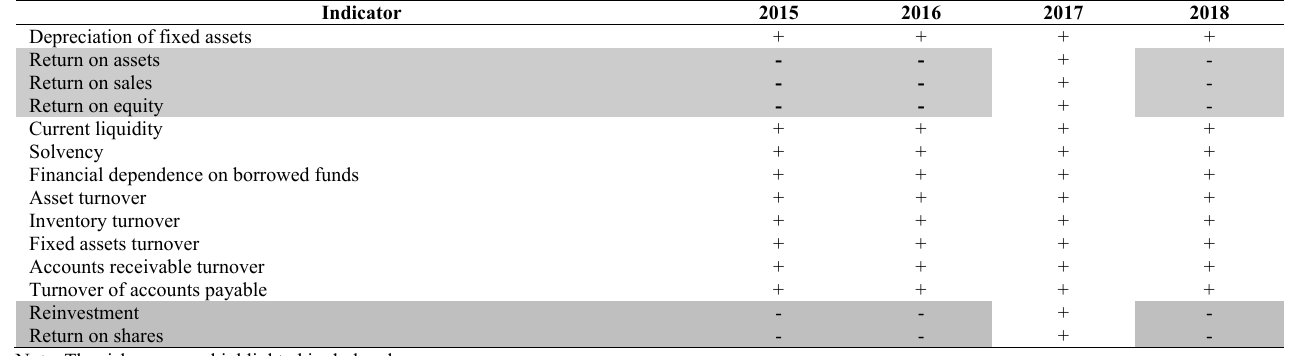
The scope of the restraining and stimulating financial risks of PJSC “Elektrothermomethriya” Indicator